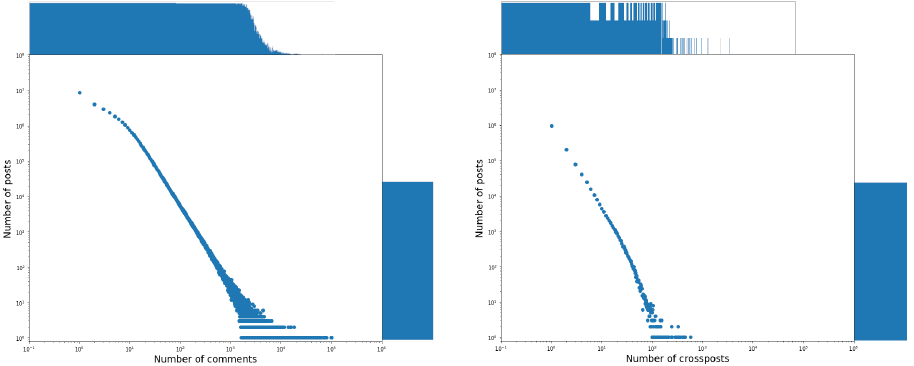
Figure 1. Distributions of posts against comments ( left , log–log scale) and crossposts ( right , log–log scale) enriched with marginal distributions.